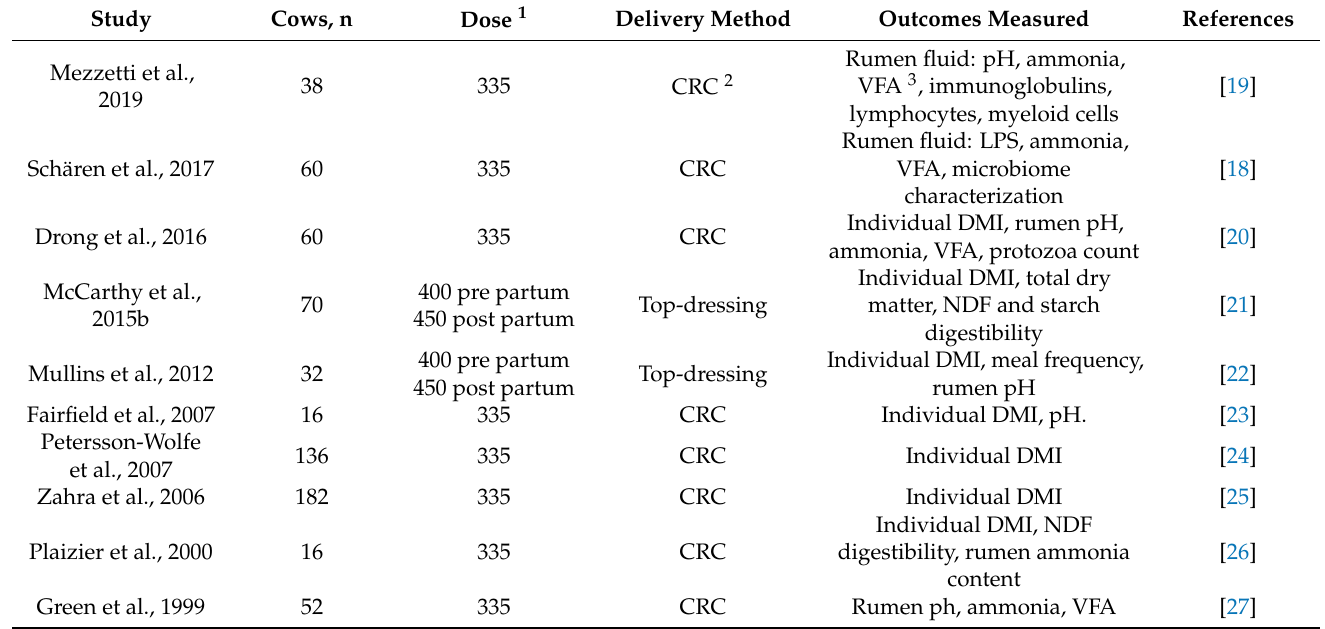
Table 1. Studies evaluating the effect of monensin during transition period on feed intake and rumen